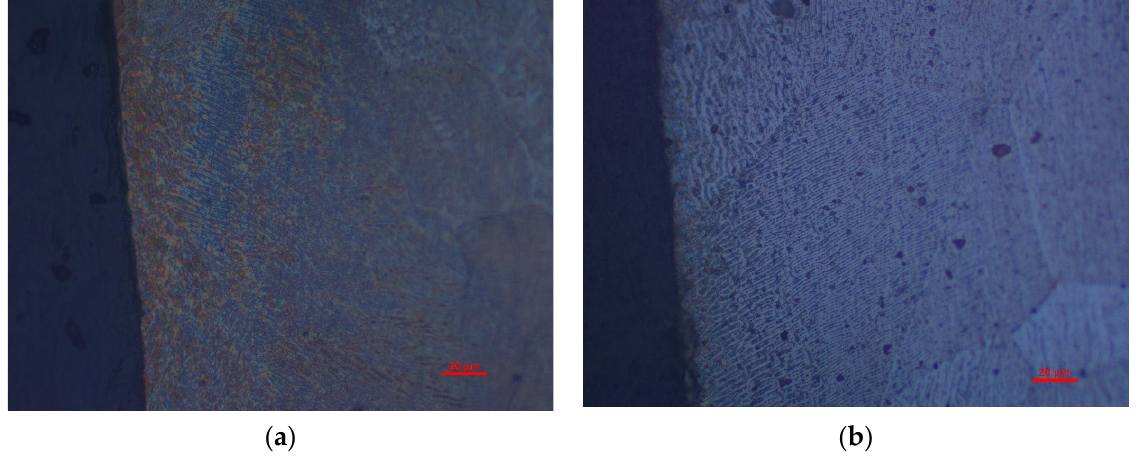
Figure 12. Magnetic domain structures near the cut edge of No. 7 sample ( a ) before and ( b ) after annealing.